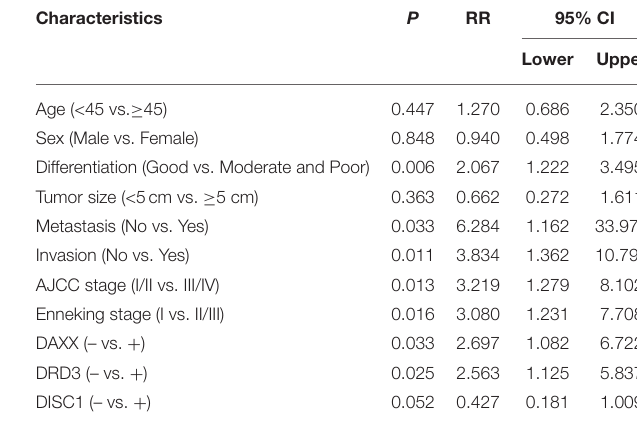
TABLE 4 | Associations of DAXX, DRD3, and DISC1 expression and clinicopathological characteristics with overall survival in patients with chondrosarcoma, as determined by multivariable Cox